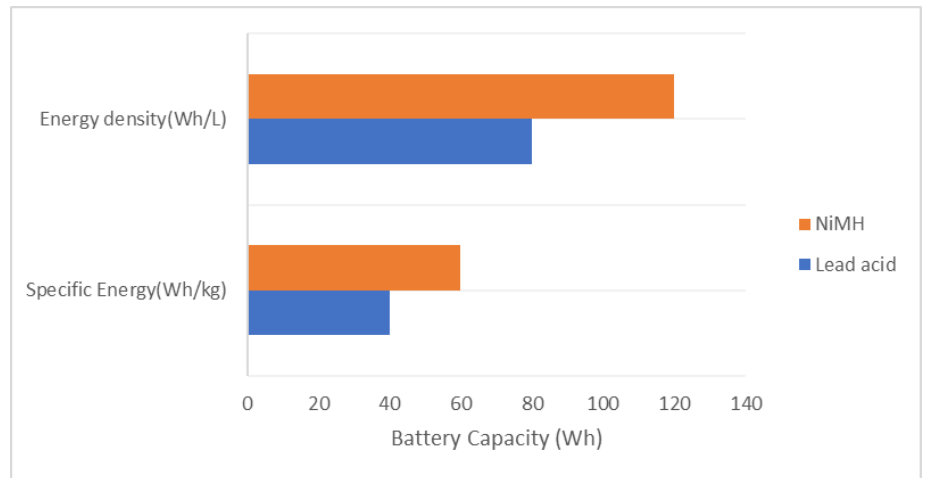
Figure 3. Comparison of Ni-MH and lead-acid batteries.